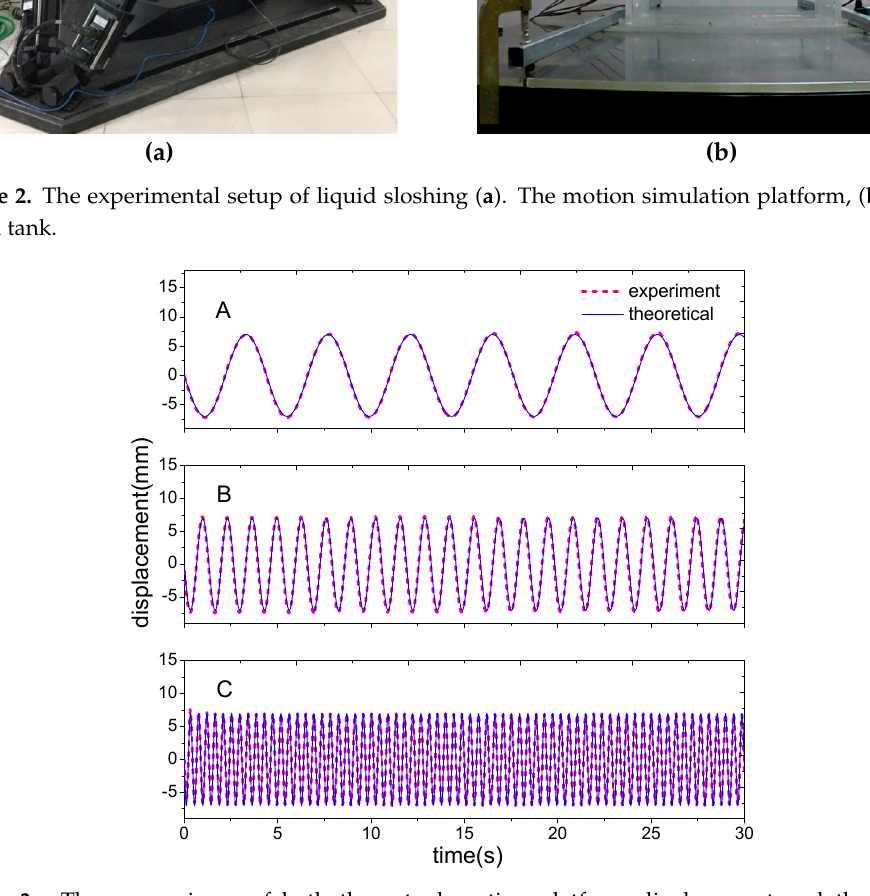
Figure 3. The comparisons of both the actual motion platform displacement and theoretical displacement (amplitude is 7 mm, ω A = 1.425 rad/s, ω B = 4.749 rad/s, ω C = 14.249 rad/s).